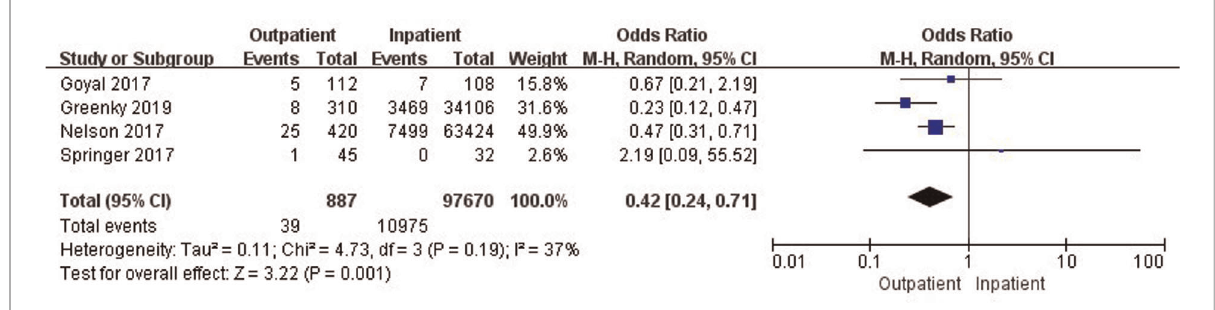
FIGURE 3 Comparison of 30-day total complications between outpatient and inpatient THA.